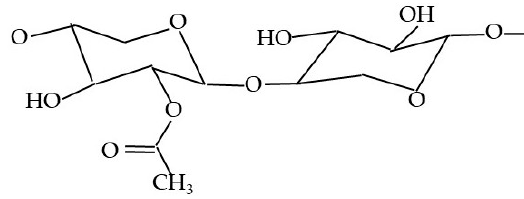
Figure 4. Chemical structure of xylan.